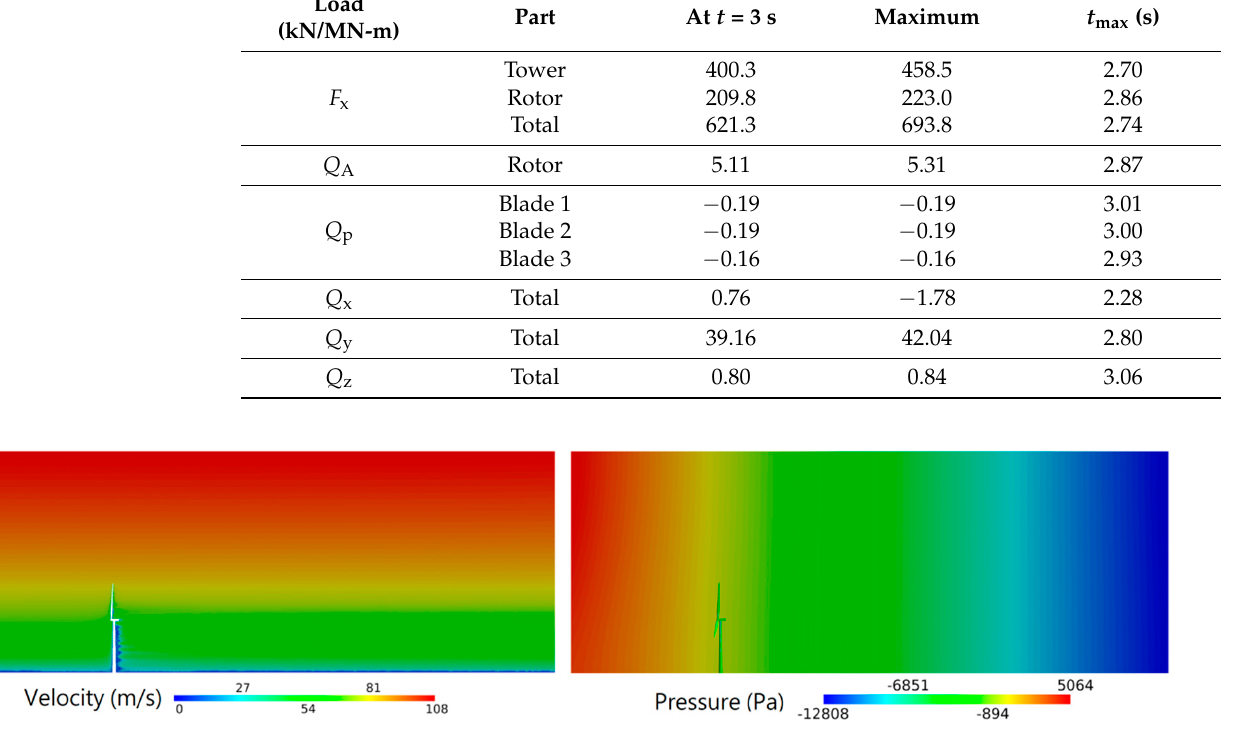
Figure 15. Velocity and pressure contours on the centerplane of wind field at t = 2.0 s.